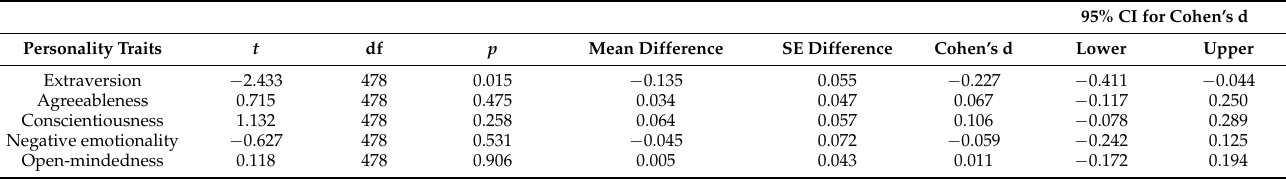
95% CI for Cohen’s d